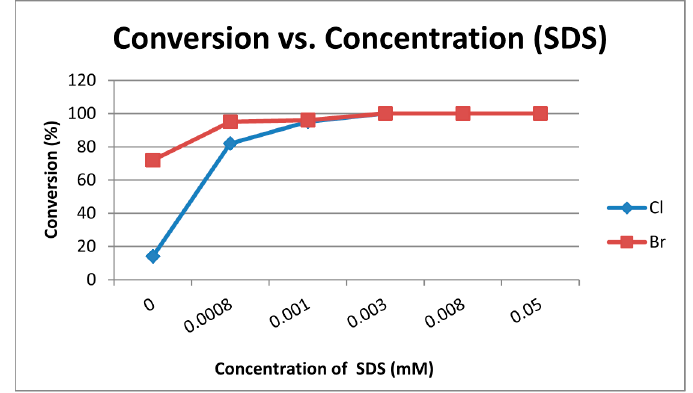
Figure 1. Effect of the added amount of sodium dodecyl sulphate (SDS) amphiphile on the efficiency of the reaction of 1,1-diphenylethanol ( 1 ) with N -halosuccinimide (NXS).